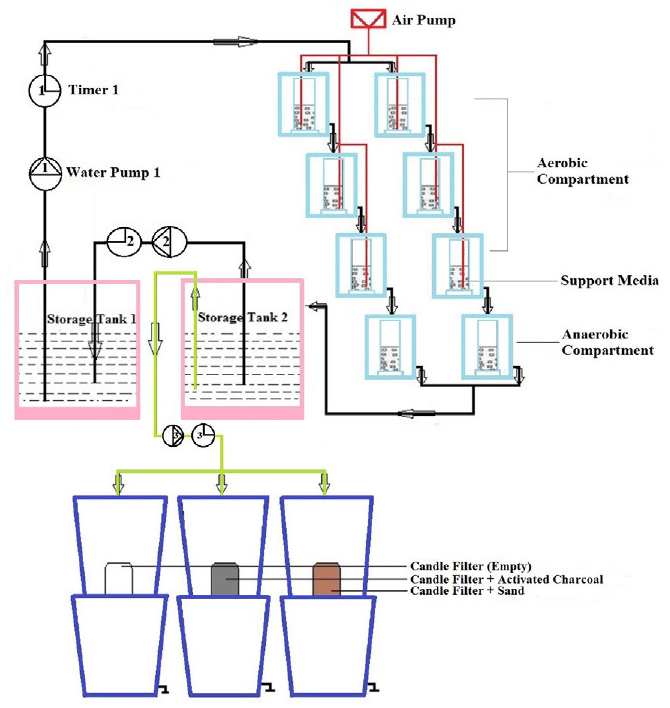
Fig. 1: Configuration of remediation setup